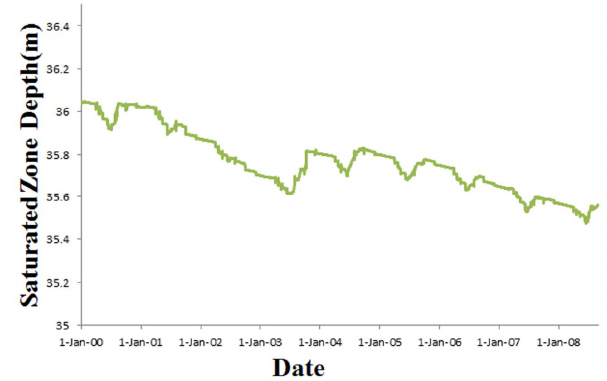
Fig. 12. Saturated zone storage depth over time of the study area Fig.12. Saturated zone storage depth over time of the study area from 2000 to 2008. 1061 from 2000 to